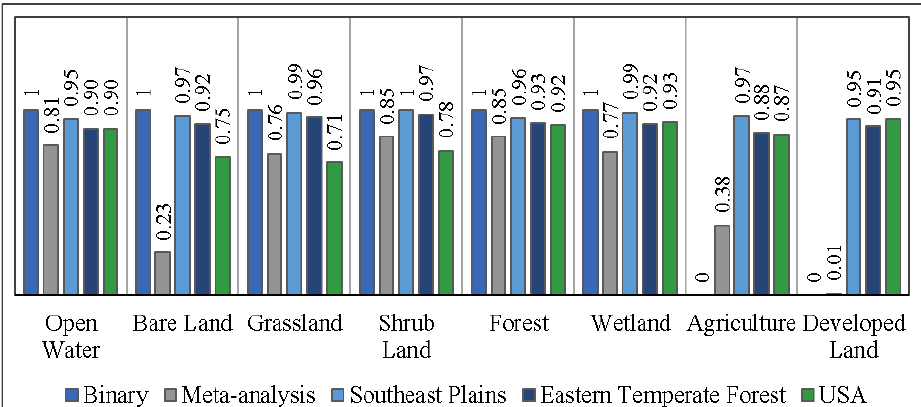
Figure 7. The habitat suitability index for the various land use/cover